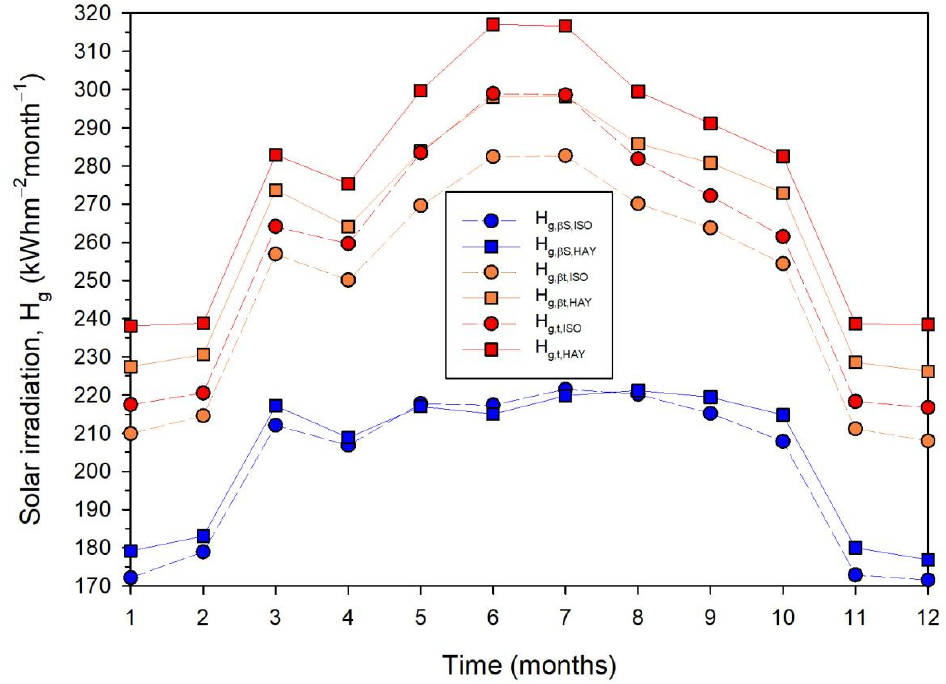
Figure 8. Intra-annual variation of the solar energy yields, H g , averaged across the 82 sites in Saudi Arabia and the period 2005–2016 under all-sky conditions. The values are shown for the 3 solar system configuration modes and both ISO- and HAY-modelled results. The months on the x-axis are from January (1) to December (12).